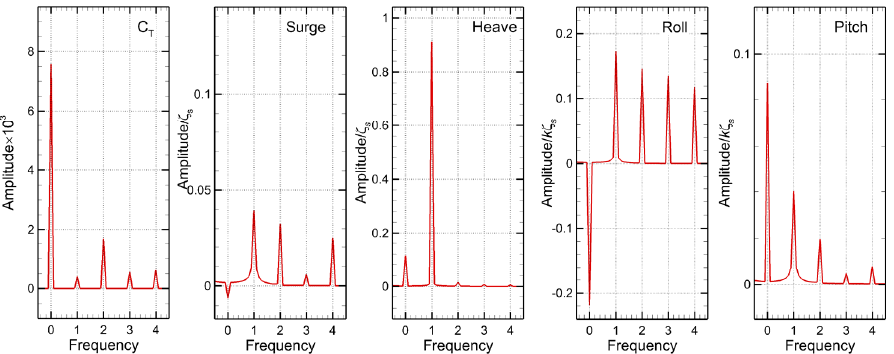
Figure 20. Harmonic amplitudes of the total resistance coefficient ( C T ) , surge ( x ) , heave ( z ) , roll ( ϕ ) , and pitch ( θ ) for the beam waves FRxz ϕθ scenario.